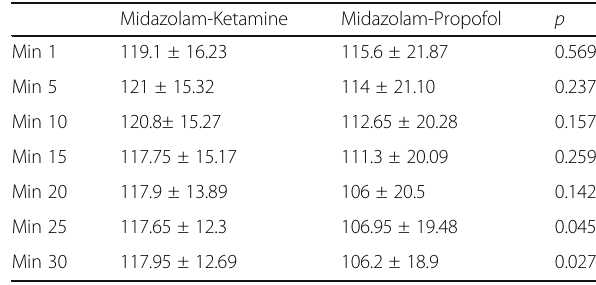
Table 7 Heart rate ( HR)